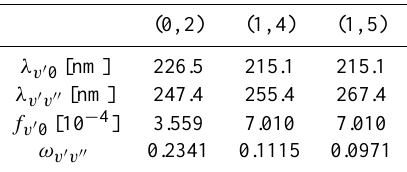
Table 1. NO emissivity parameters used in the paper for the three NO gamma bands used for the retrieval.